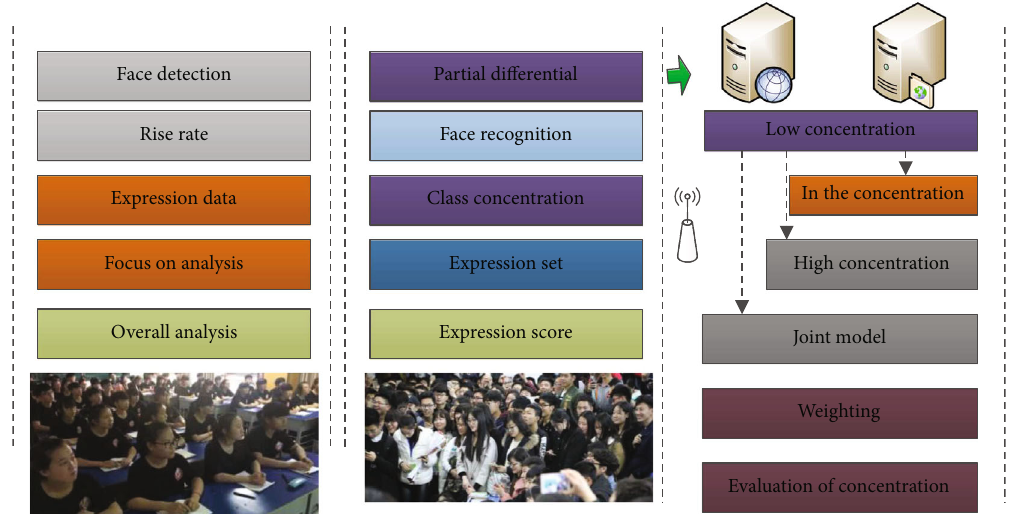
Figure 3: Face recognition concentration analysis and evaluation model based on partial di ff erential equation of expression and head-up rate.